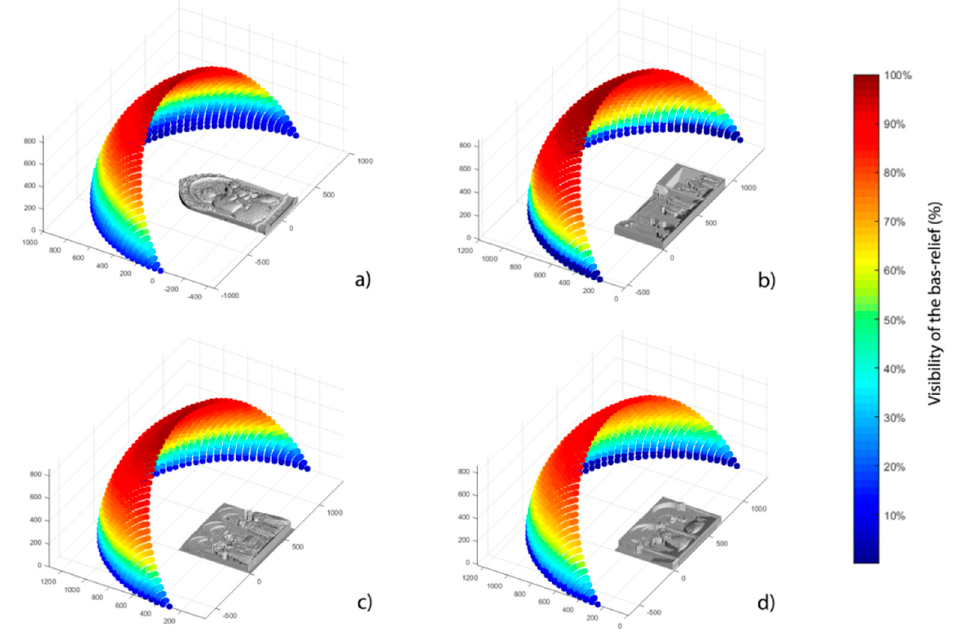
Figure 8. Visibility analysis for bas-reliefs; ( a ) “Madonna con Bambino e Angeli” by Niccolò Gerini di Pietro; ( b ) “Guarigione dello storpio e resurrezione di Tabita” by Masolino da Panicale; ( c ) ”Pala di Santa Lucia de’ Magnoli” by Domenico Veneziano; ( d ) ”Annunciazione” by Beato Angelico.